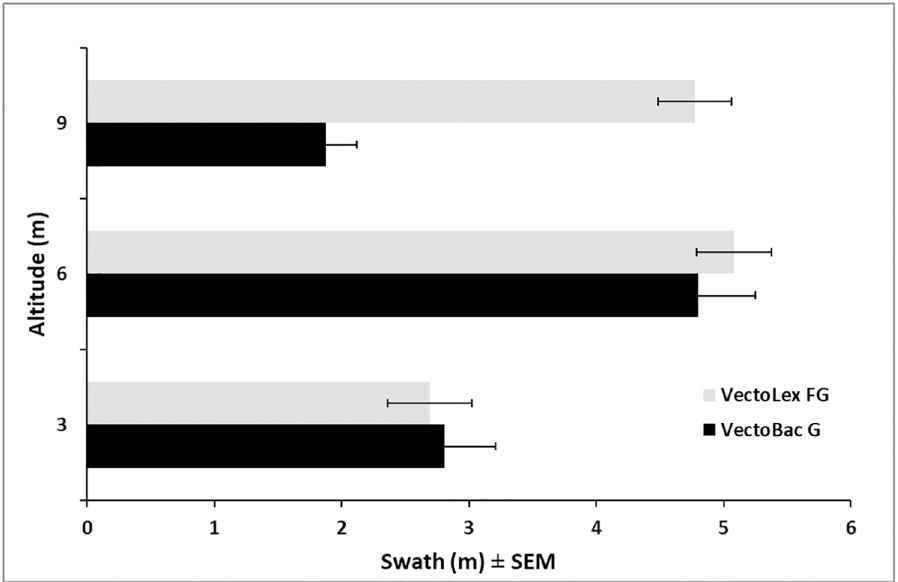
Fig 4. Effect of altitude on swath width of VectoLex FG and VectoBac G larvicidal granules applied from a UAS ±